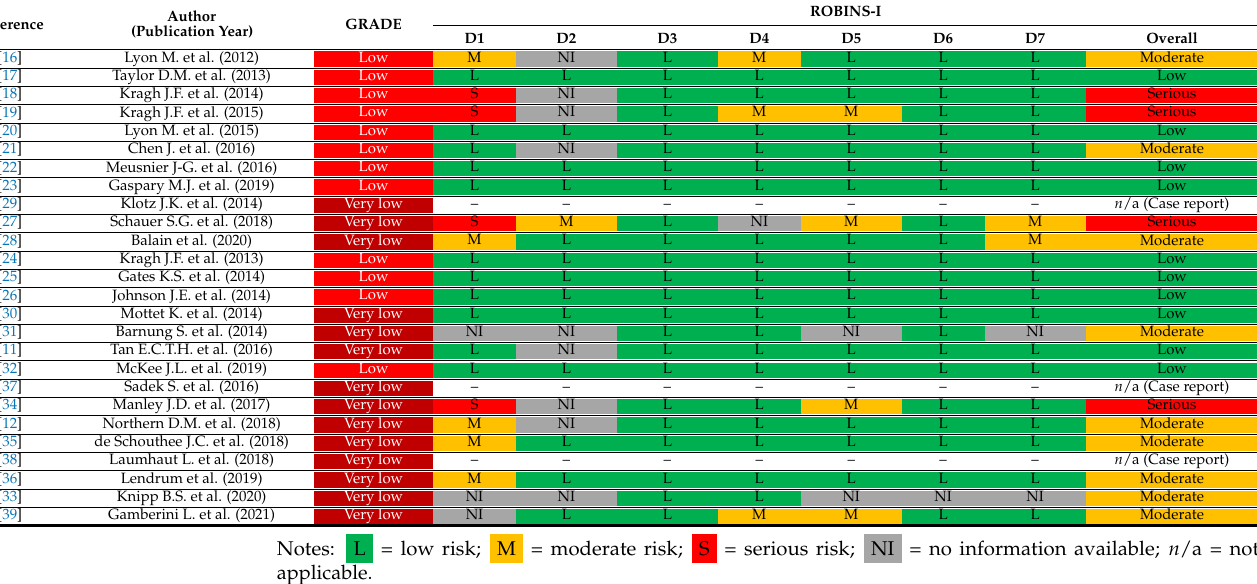
Table 7. Quality of evidence (GRADE) and risk of bias assessment (ROBINS-I); Domain D1: Con- founding bias; D2: Participant selection bias; D3: Intervention classification bias; D4: Intervention deviation bias; D5: Missing data bias; D6: Outcome measurement bias; D7: Selective reporting